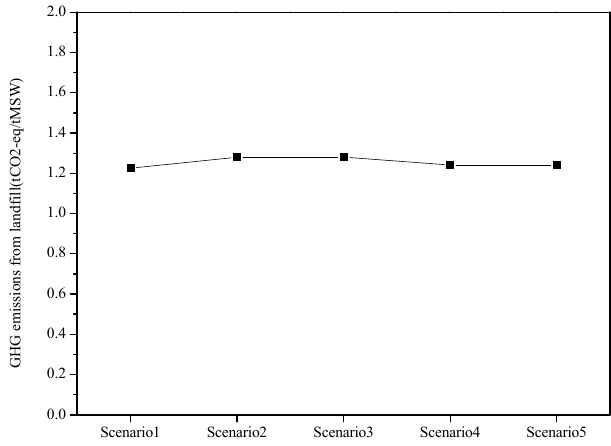
Figure 10. GHG emissions from MSW landfill under five scenarios.